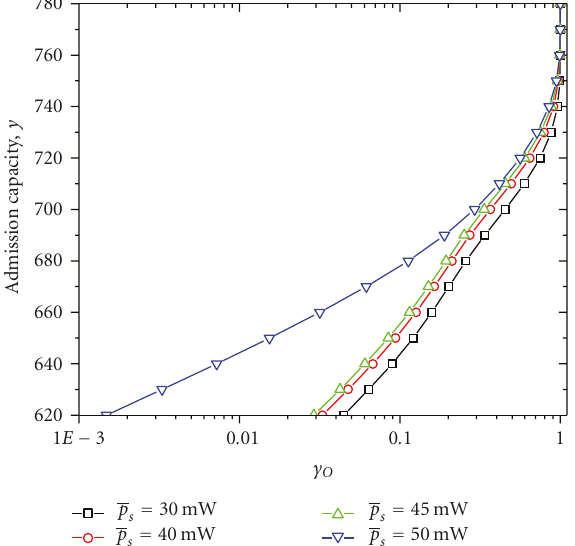
Figure 4: The maximum number of connections y versus γ O with = p = 50mW, σ 2 = 10 − 11 , φ = 100 Kbps). respect to BER ( p s r